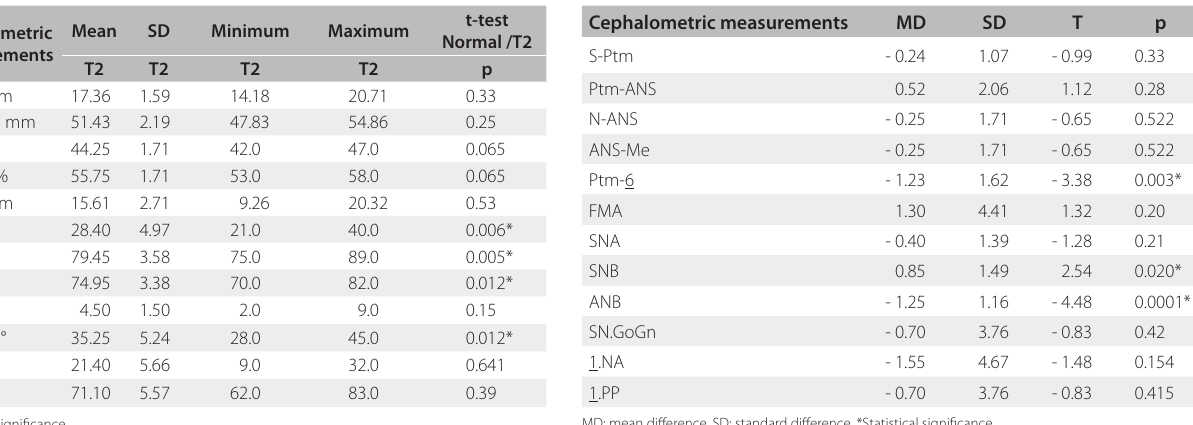
Table 3. Comparison of starting forms at T2 Table 4. Comparison of changes during treatment T1 to T2